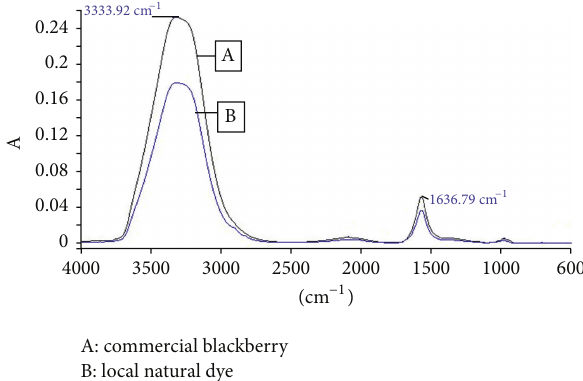
Figure 11: Absorption characteristic of commercial, A, and local natural dye, B.